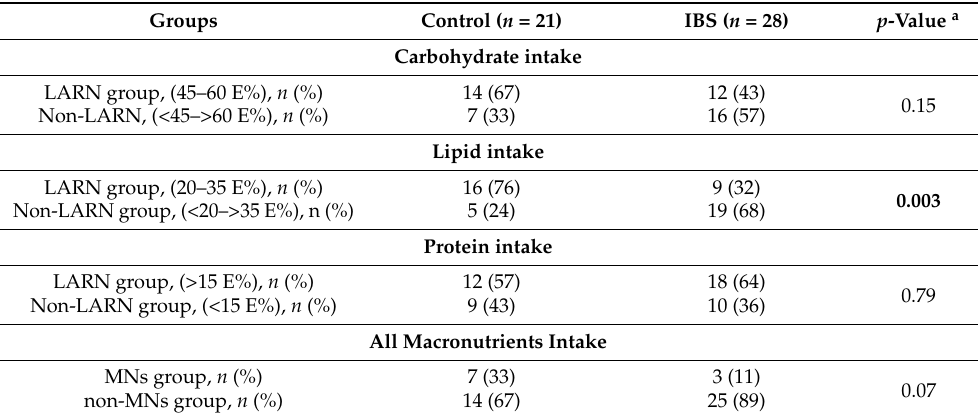
Table 3. The division of IBS and controls into the “LARN” and “non-LARN”